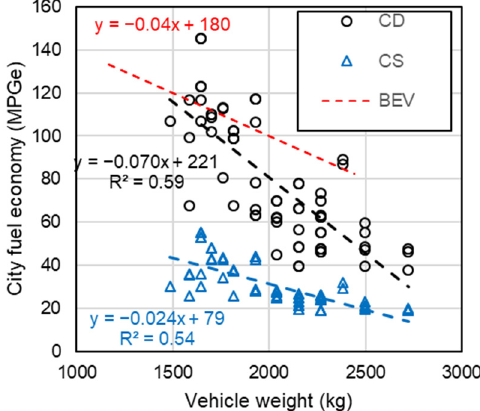
Figure 3. Trend of EPA city (MPGe) fuel economy with vehicle curb weight (kg). Black represents PHEV in CD mode; blue represents PHEV in CS mode and red represents BEV.